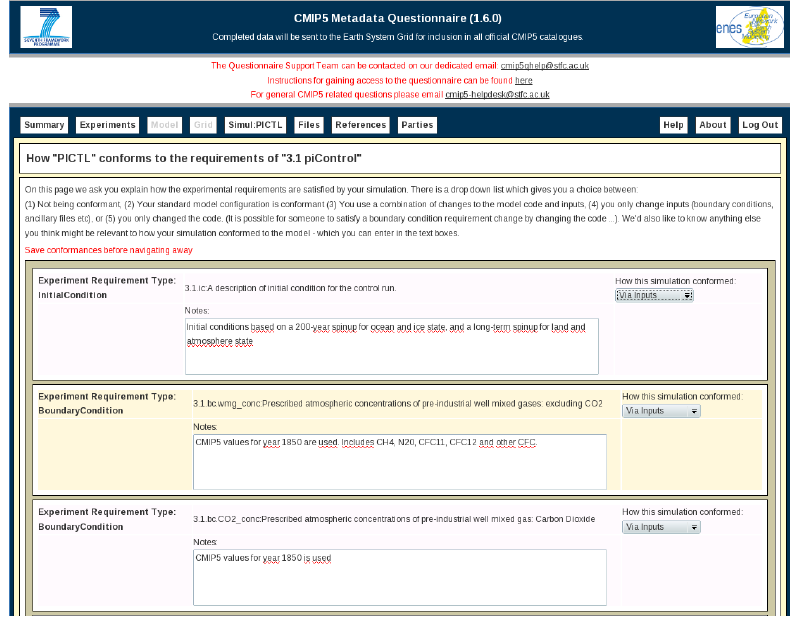
Fig. 8. Illustration of the “Conformance” concept in the case of a PICTL simulation performed with CNRM-CM5 model in the framework of 3.1 piControl CMIP5 experiment . For the three requirements shown, the conformance is ensured via inputs , which means that the input files used contain the forcings requested. Note that a free-text area to enter additional details is always